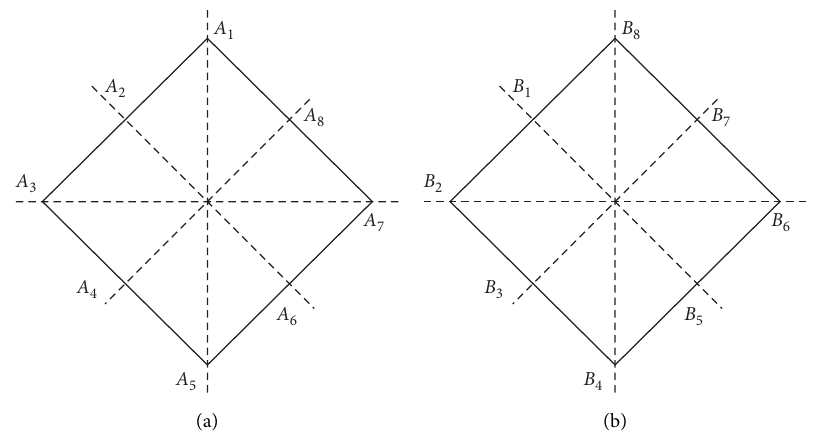
Figure 1: Self-shape fusion diagram: (a) source shape and (b) target shape.